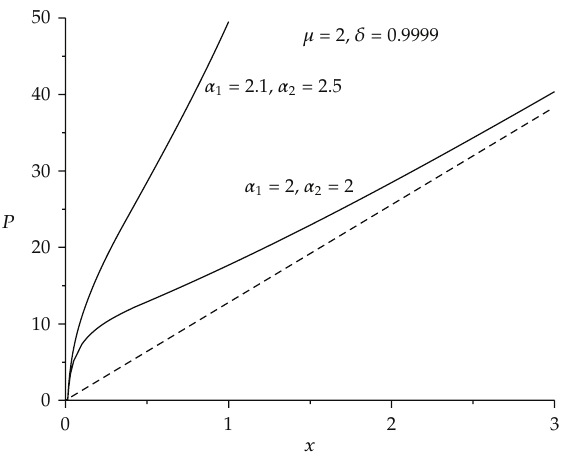
Figure 2: Curves of P ∼ x for α 1 ,α 2 > 1.